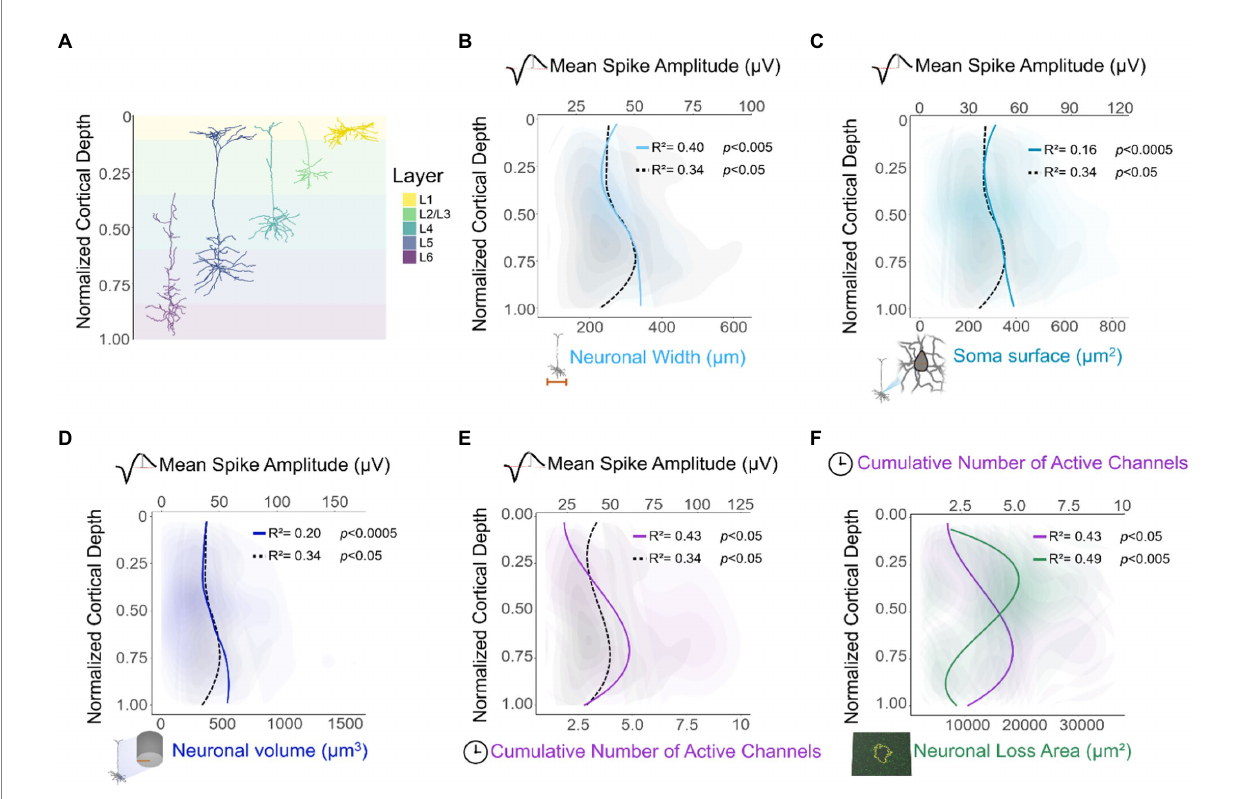
FIGURE 9 Relationship between histological, electrophysiological, and morphological features of neurons across cortical depth. (A) Representative diagram of individual neuronal reconstructions across cortical layers (Senzai et al., 2019). (B–F) Locally weighted scatterplots and locally fitted polynomial regressions were applied for visualization purposes. Additionally, a nonlinear correlation across cortical depth was computed via spatial sampling. To assess the relationship between depth-dependent recording patterns of this study and neuronal morphology, morphological features were extracted from 3D reconstructions of mouse cortical neurons ( n = 513) (Senzai et al., 2019). Neuronal width (B) , soma surface area (C) , and volume of the entire neuron (D) were compared in relationship with the mean spike amplitude across normalized cortical depth (same data as Figure 2B). Cumulative number of channels with active spikes across cortical depth (same data as Figure 3B) and its relationship with (E) mean spike amplitude (same data as Figure 2B), and (F) neuronal cell loss (same data as Figure